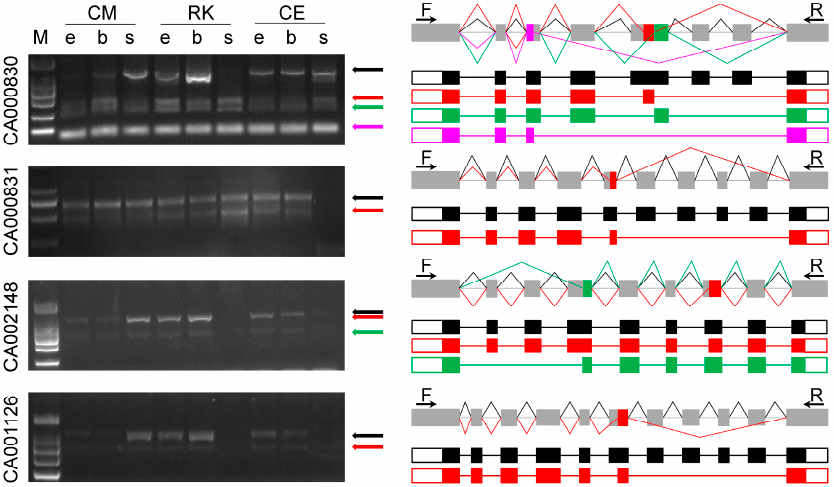
Figure 3. Alternative splicing verification by RT-PCR. CM, RK, and CE represent Common, Ryukin, and Celestial-Eye goldfish, respectively. e: 30% epiboly stage, b: bud stage, s: 14-somite stage. F and R represent forward and reverse primers used for RT-PCR.